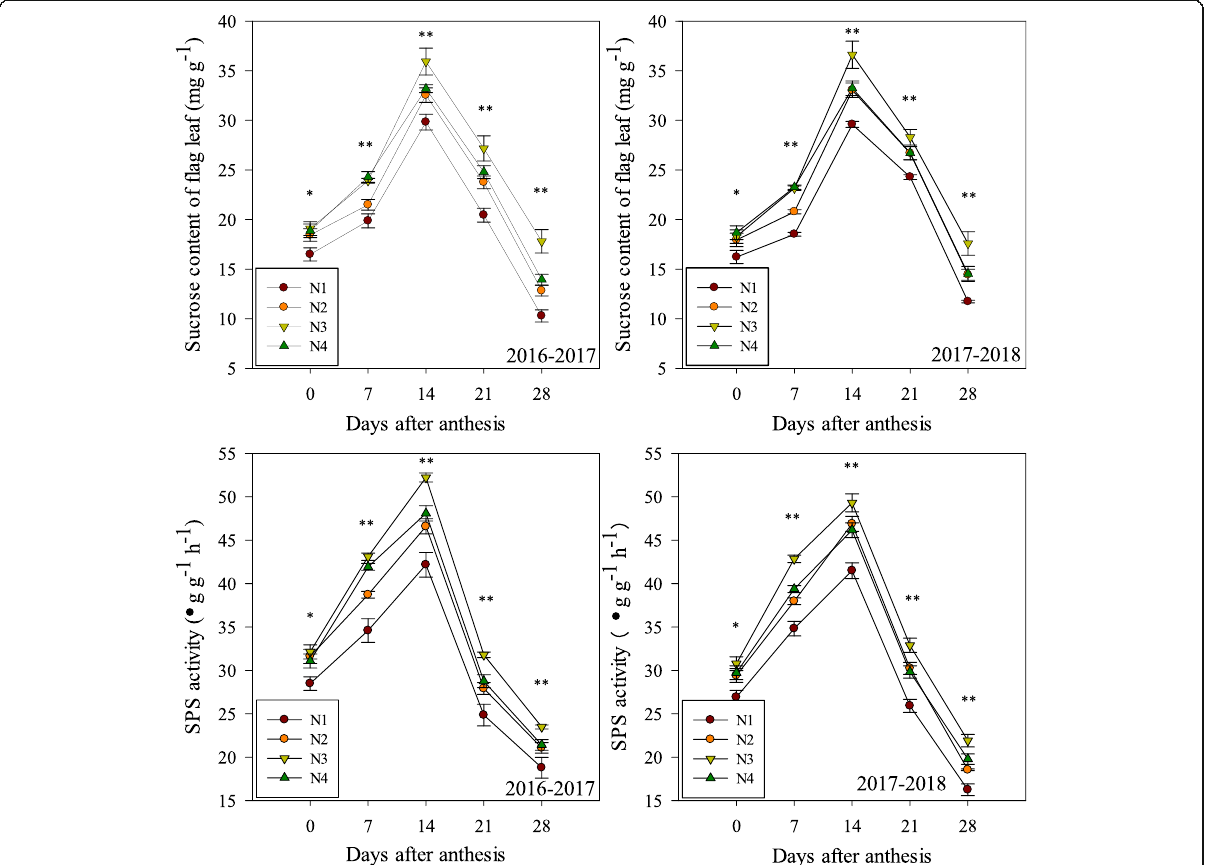
Fig. 4 Effects of four split nitrogen fertilizer treatments on flag leaf source content and SPS activity at 0 days, 7 days, 14 days, 21 days, and 28 days after anthesis. ns, not significant; ** P < 0.01; * P <